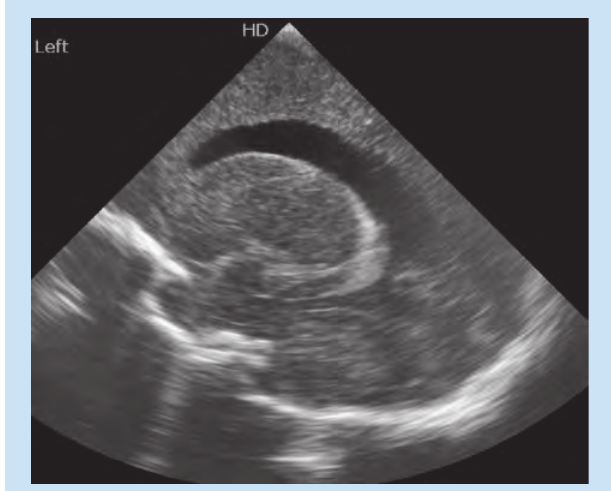
Fig. 1. Parasagittal US scan through the body of the left lateral ventricle.